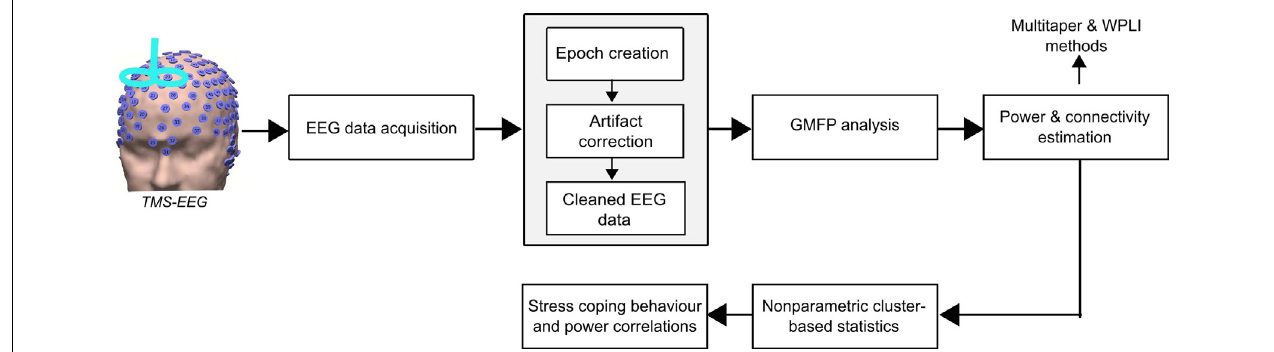
FIGURE 2 | Electroencephalography data were acquired from the no-TMS and TMS experiments. The data were segmented into epochs and excluded the TMS-related artifacts (ringing, decay, and muscle), and non-TMS artifacts (eye-blinks). Afterward, the global mean field power (GMFP) was calculated across all EEG channels for both the experiments. Further, the power and connectivity were assessed by the multitaper method with Hanning window and weighted phase lag index (WPLI), respectively. The significant differences in power and connectivity between the conditions were tested with non-parametric cluster-based statistics. Finally, the neural oscillatory power was correlated with individual stress coping